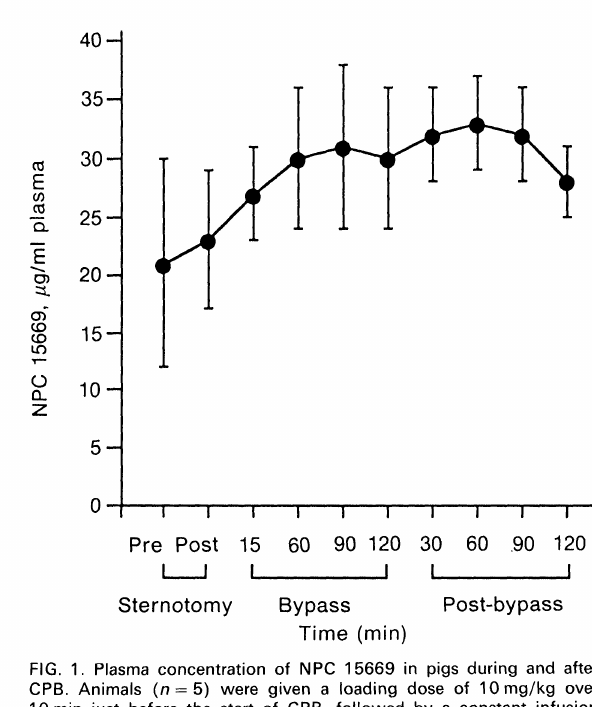
FIG. 1. Plasma concentration of NPC 15669 in pigs during and after CPB. Animals (n 5) were given a loading dose of 10mg/kg over 10 min just before the start of CPB, followed by a constant infusion .at 6mg/kg/h. A stable plasma concentration of approximately 30/g/ml was achieved using this